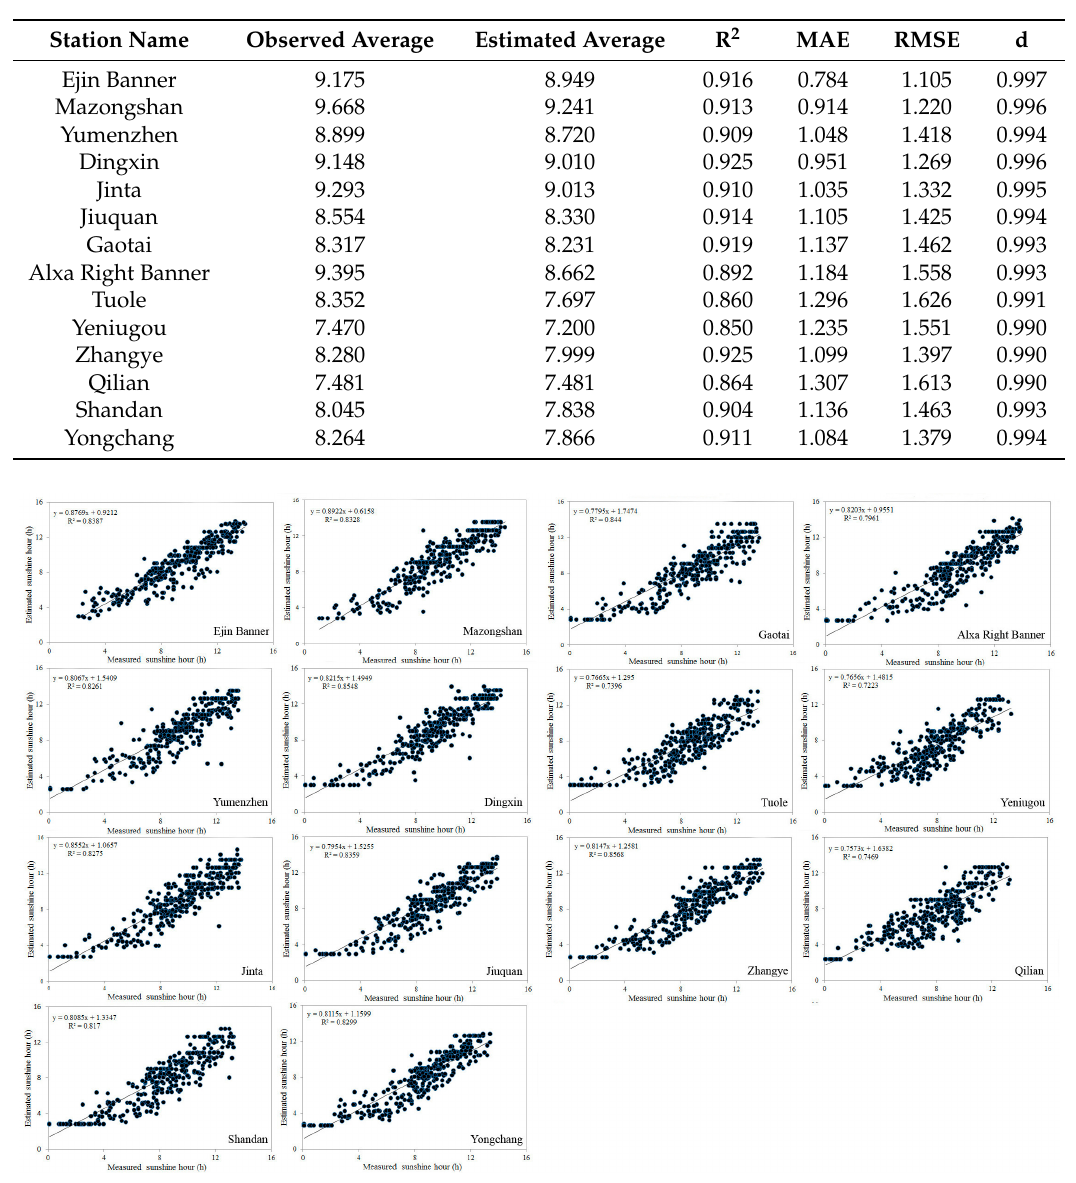
Figure 2. Comparison of the measured sunshine duration and estimated sunshine duration the different meteorological station over the Heihe River Basin in 2008.